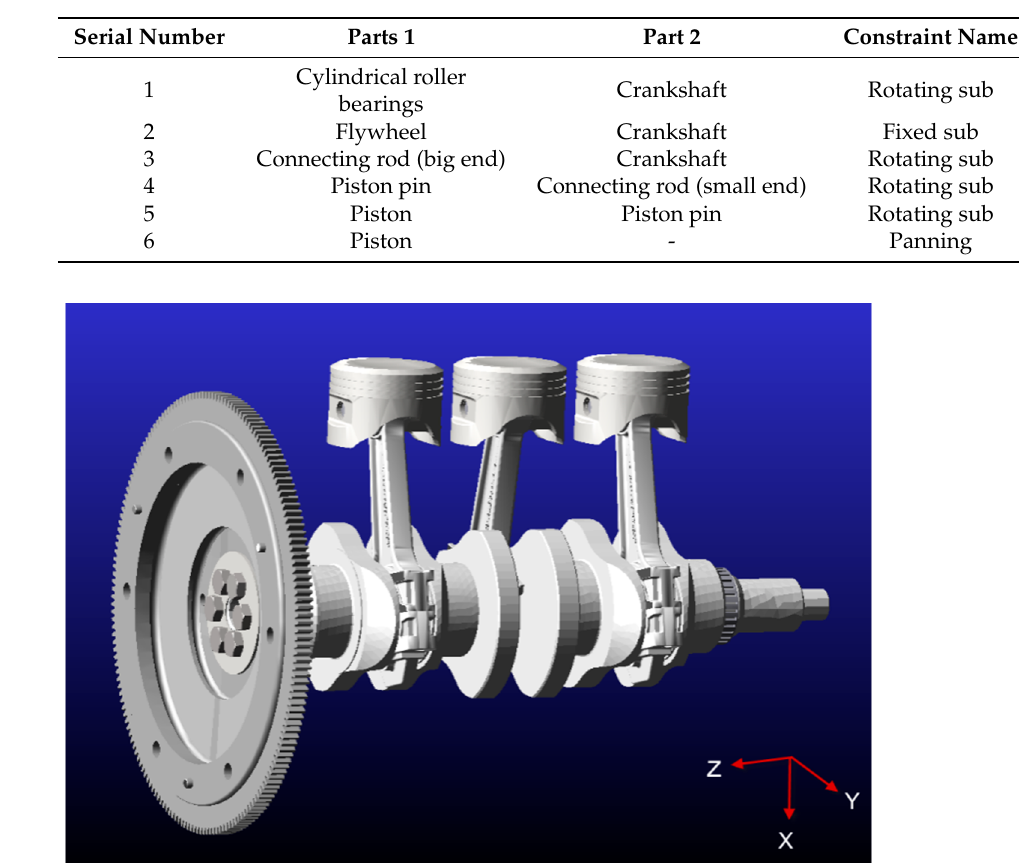
Table 5. Constraint relationship of each component of the shaft system.